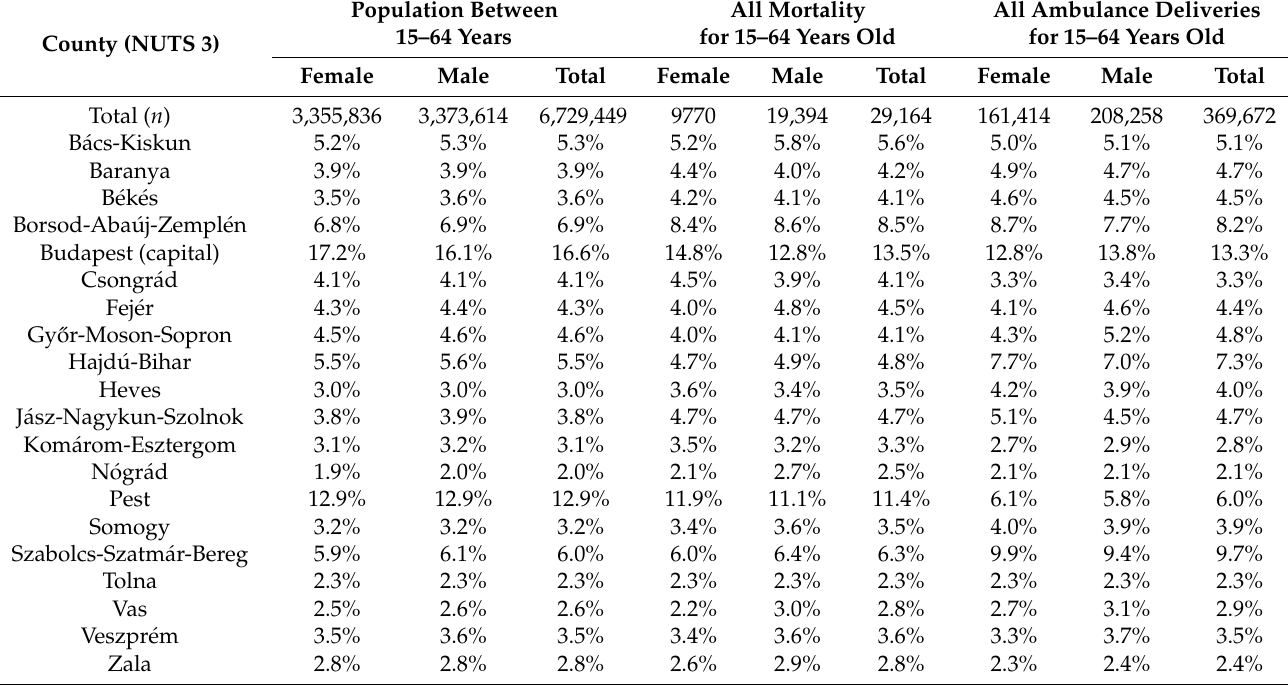
Table 1. Percentage of the overall Hungarian population, mortality and ambulance deliveries between the ages 15–64 years in 2018 at the county